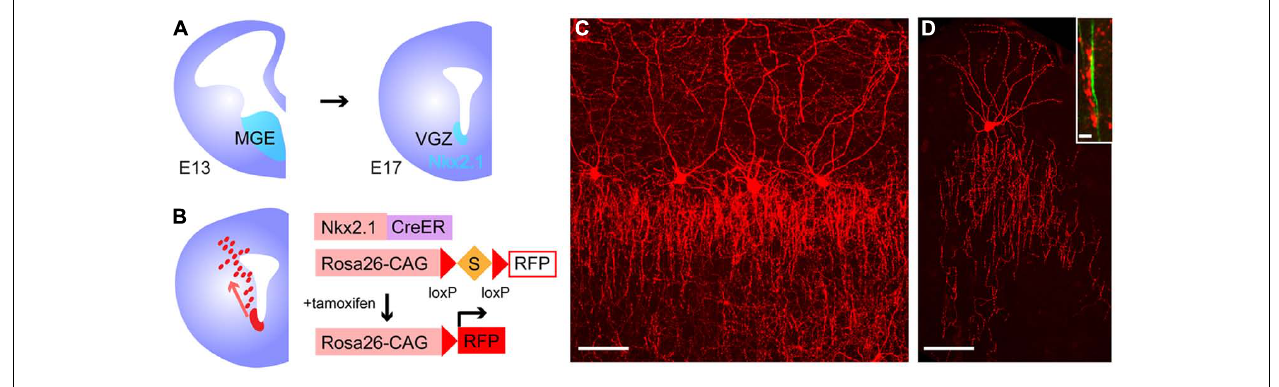
FIGURE 6 | Genetic targeting of chandelier cells. (A) Expression of Nkx2.1 in the ventral forebrain during mid-late gestation. Nkx2.1 is expressed in the MGE during mid-gestation. Even after the MGE became morphologically invisible, Nkx2.1 continues to be expressed in the VGZ during late gestation. (B) Genetic fate mapping of ChC progenitors using Nkx2.1-CreER driver lines and Cre-dependent reporters. CreER-mediated excision of a stop cassette is induced by addition of tamoxifen and results